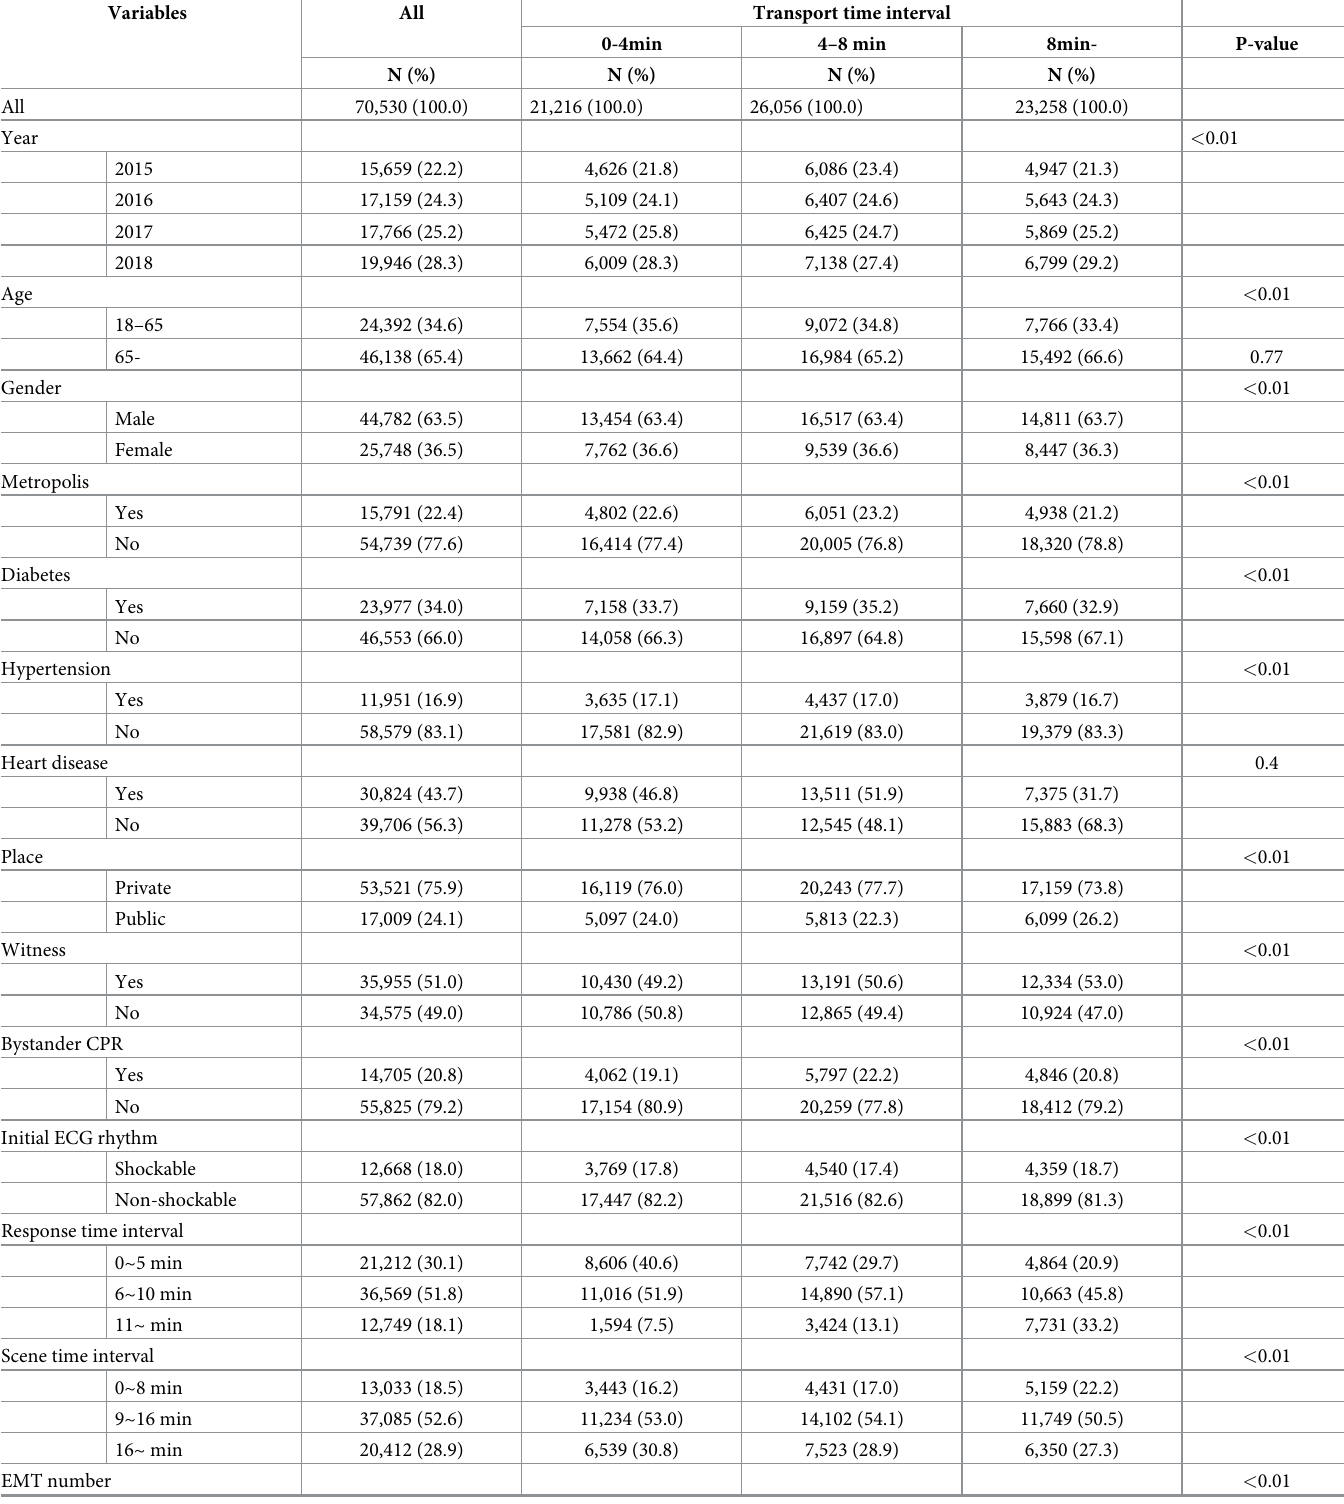
Table 2. Characteristics of out-of-hospital cardiac arrest patients by transport time